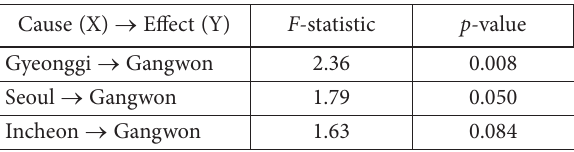
Table 3. Result of Granger causality test Cause (X) → Effect (Y) F